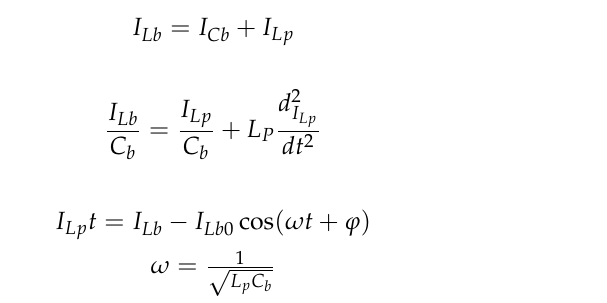
whose solution is: